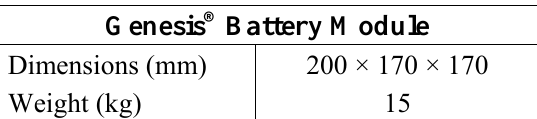
Table 3. Battery Module.